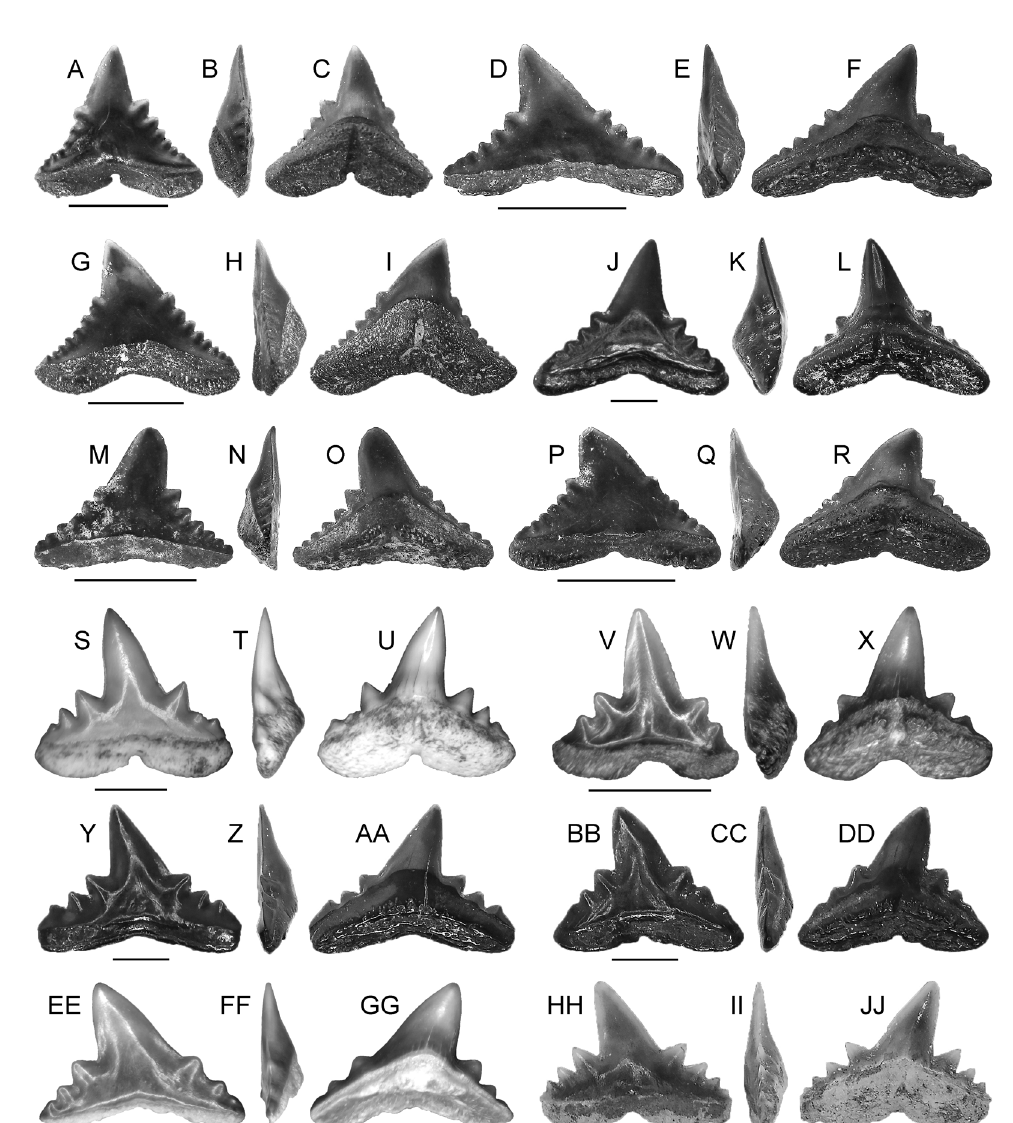
Fig. 32. Pseudabdounia claibornensis (White, 1956) gen. et comb. nov. and P. recticona (Winkler, 1874) gen. et comb. nov., teeth. A–R . P. claibornensis gen. et comb. nov. A–C . MSC 37591, anterior tooth, basal Gosport Sand. A . Labial view. B . Mesial view. C . Lingual view. D–F . MSC 37563.20, lateral tooth, basal Gosport Sand. D . Labial view. E . Mesial view. F . Lingual view. G–I . MSC 37563.16, lateral tooth, basal Gosport Sand. G . Labial view. H . Mesial view. I . Lingual view. J–L . MSC 188.88, lateral tooth, basal Gosport Sand. J . Labial view. K . Mesial view. L . Lingual view. M–O . MSC 37563.28,